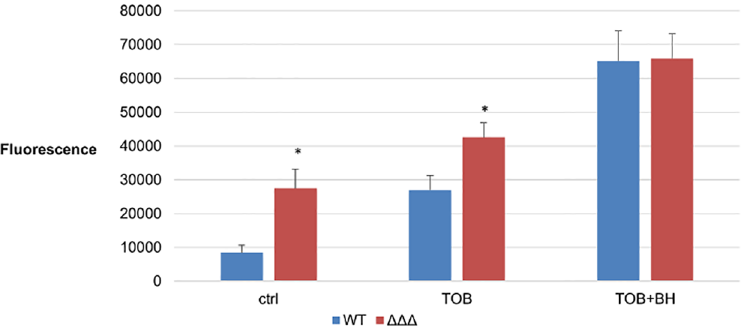
Fig 5. ROS production in B . cenocepacia J2315 and its triple QS mutant after treatment with TOB alone or in combination with BH. Accumulation of ROS, expressed as fluorescence (average ± SD) generated after incubation with H 2 DCFDA, in planktonic cultures of B . cenocepacia J2315 and its triple QS mutant treated with TOB (4 x MIC) or the combination with BH (250 μM) and a pH-matching control after 16 hours. MIC for TOB was 256 μg/ml and 128 μg/ml for the wild type and its triple QS mutant respectively. The experiment was conducted using six biological replicates. (cid:3) : statistically significant difference compared to the wild type (p <